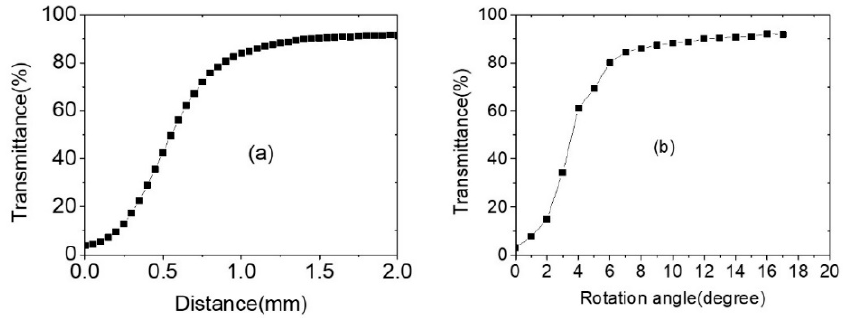
Figure 9. The transmittance of R-PCLC cell via lateral movement ( a ) and rotation movement ( b ) for incident 632.8 nm HeNe laser at 4.67 mW/cm 2 .